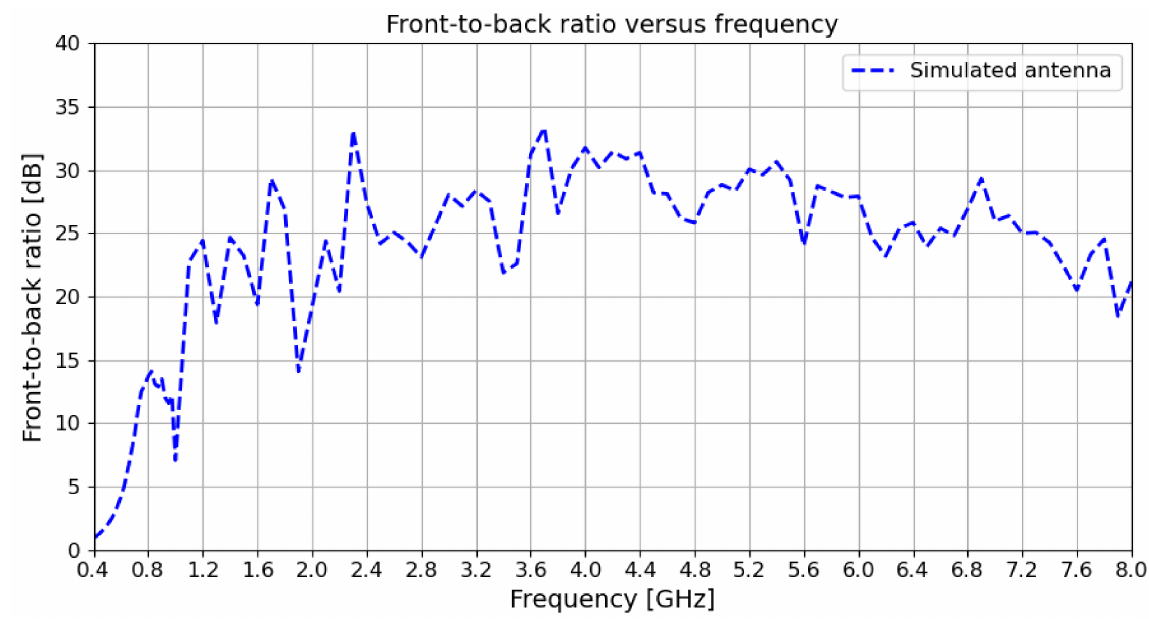
Figure 17. Front-to-back ratio of the improved PLPDA